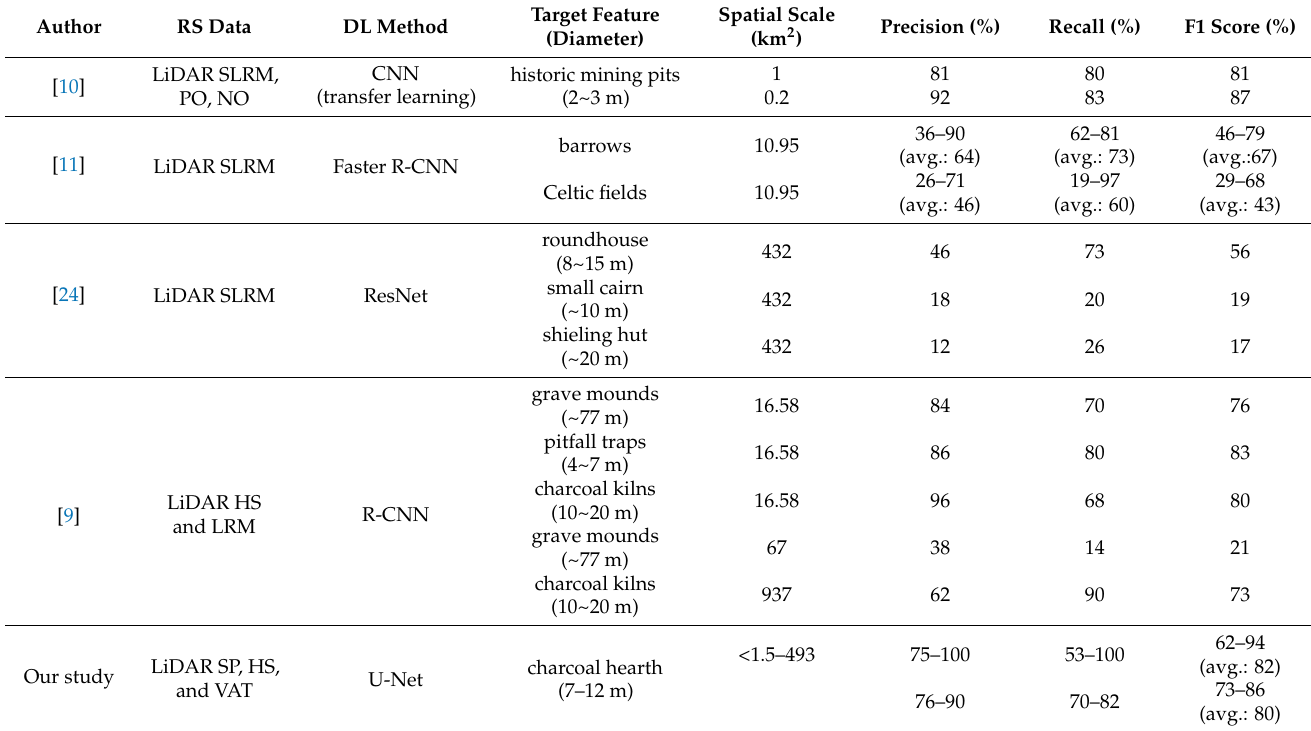
Table 7. Summary of the results (precision, recall, F1 score) of other studies that detecting anthropogenic features using